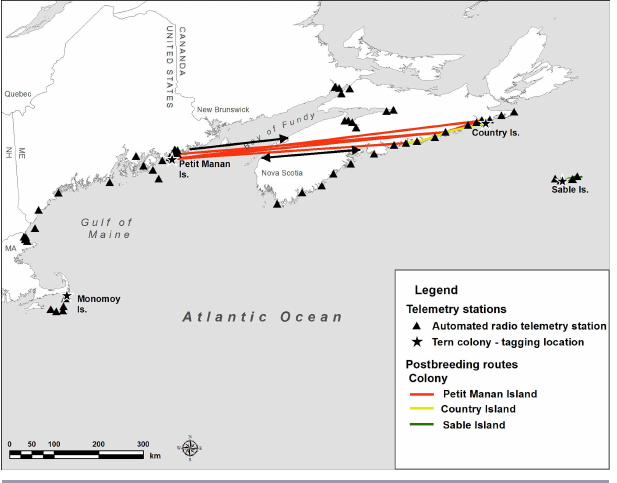
Fig. 3 . Euclidian postbreeding movements of tagged Arctic Terns ( Sterna paradisaea ; n = 52) from three nesting colonies in the northwest Atlantic, Petit Manan Island, Maine, USA (red); Country Island, Nova Scotia, Canada (yellow); and Sable Island, Nova Scotia, Canada (green), tracked by 62 automated radio telemetry stations during 2013. Black arrows show generalized direction of